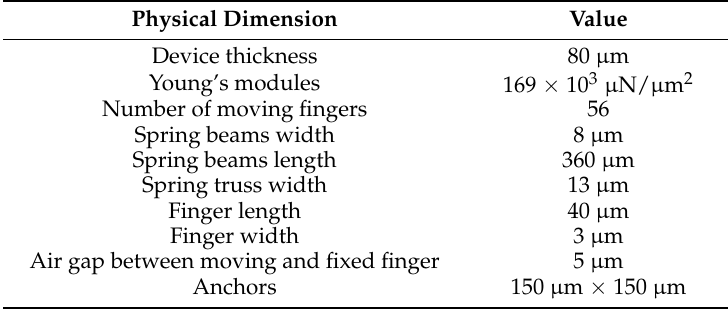
Table 2. Physical dimensions of design A microelectromechanical system (MEMS)